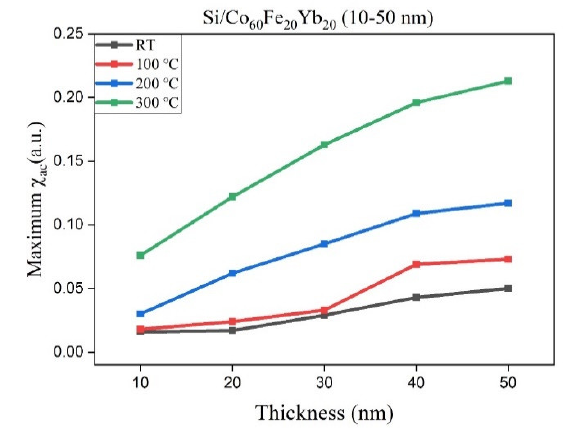
Figure 3. Maximum χ ac for the CoFeYb films. Table 1. Optimal resonant frequency for films of various thicknesses.